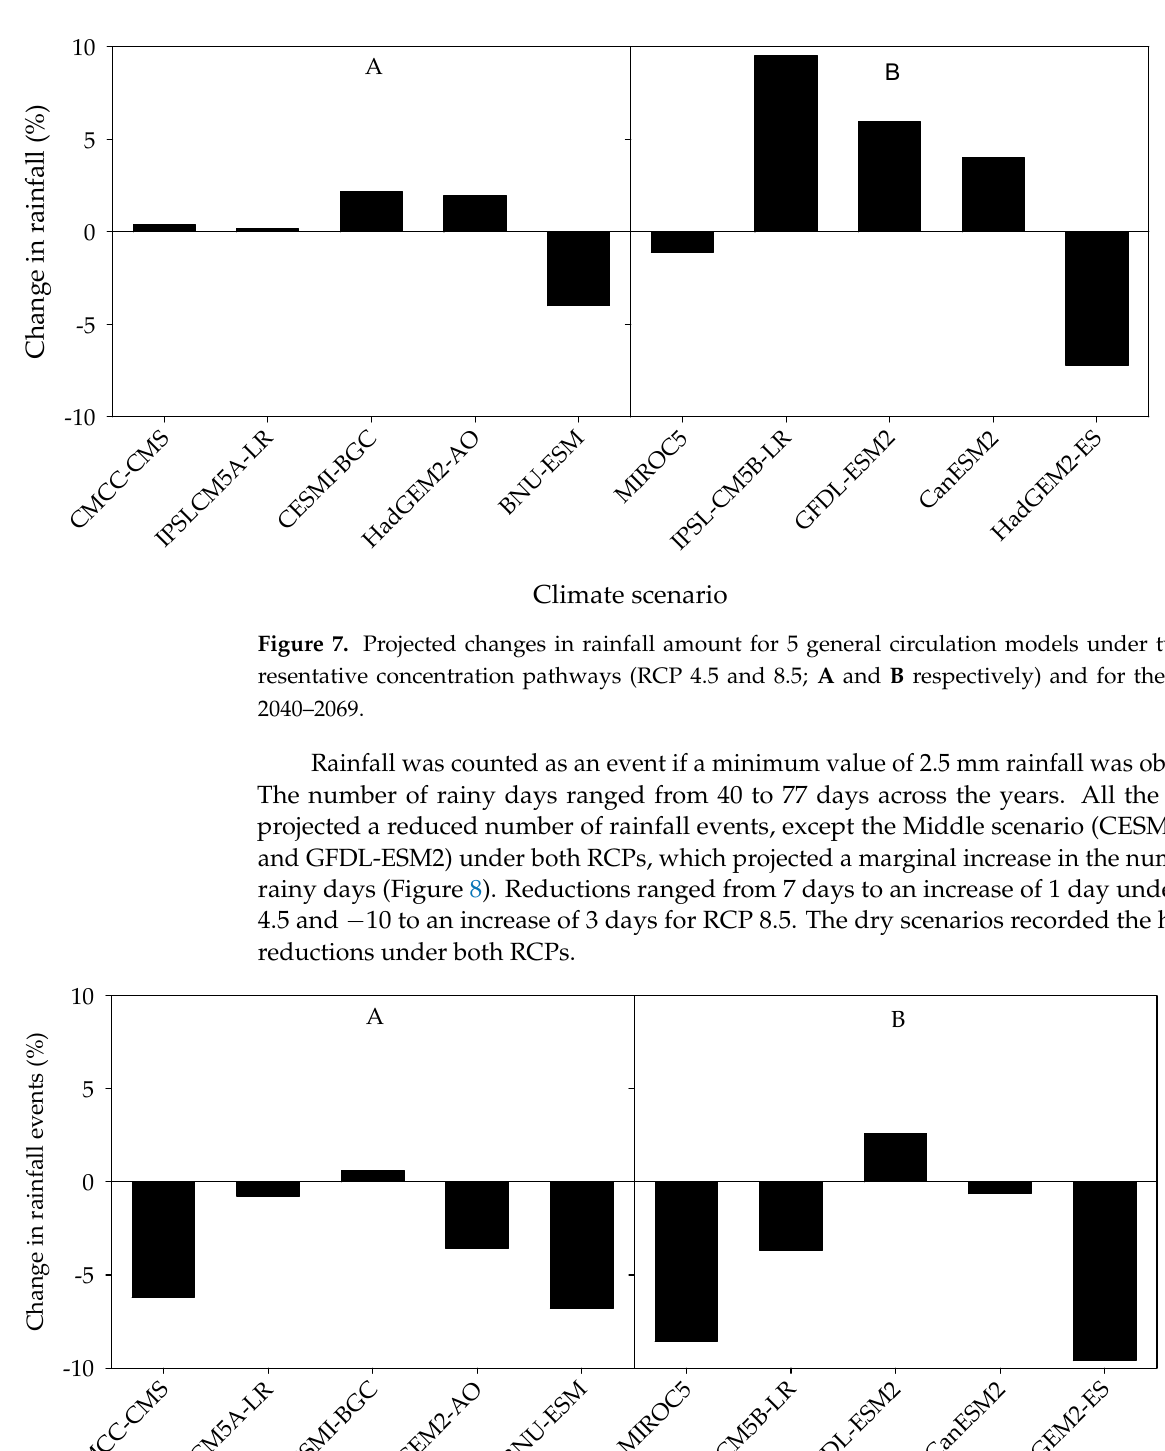
Figure 8. Projected change in rainfall events for 5 general circulation models under two representative concentration pathways (A is RCP 4.5 and B is RCP 8.5) for the period 2040–2069.